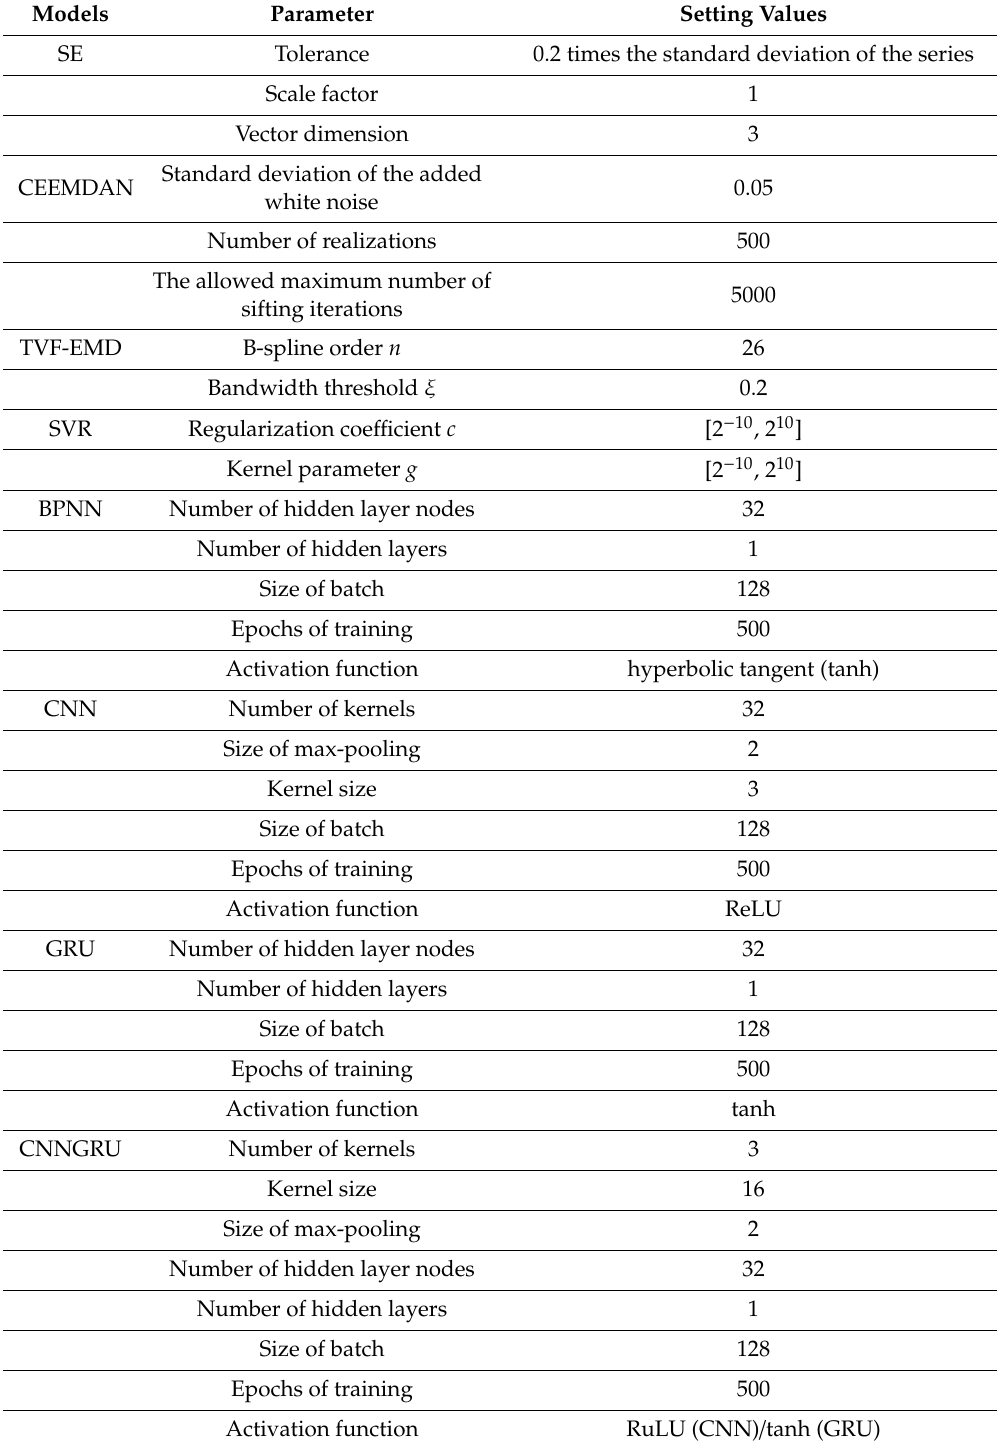
Table 2. Parameter setting for all the